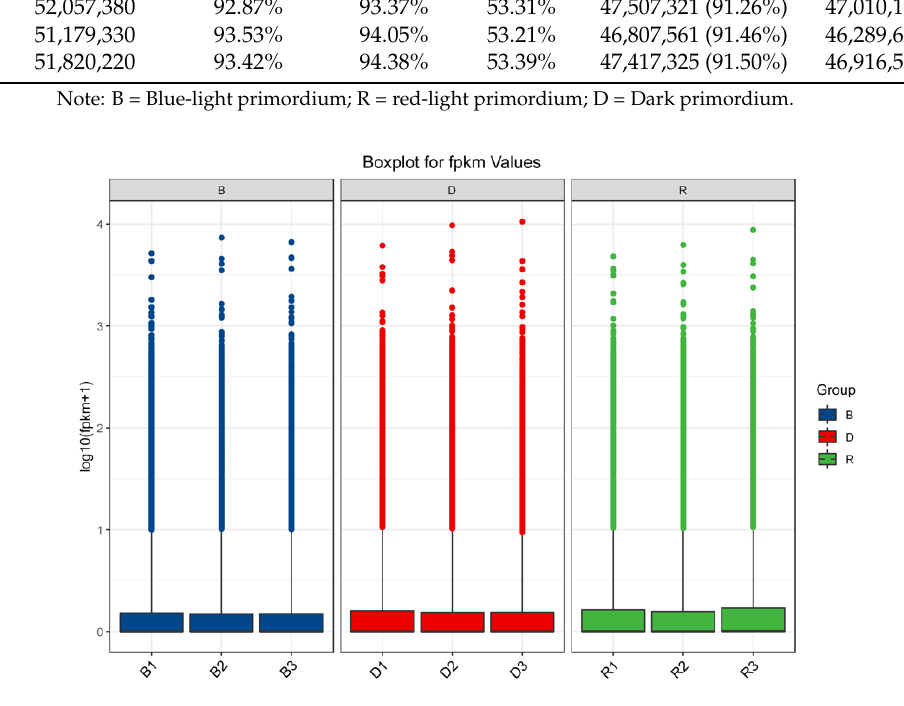
Figure 2. Transcriptional relationships among 9 samples.